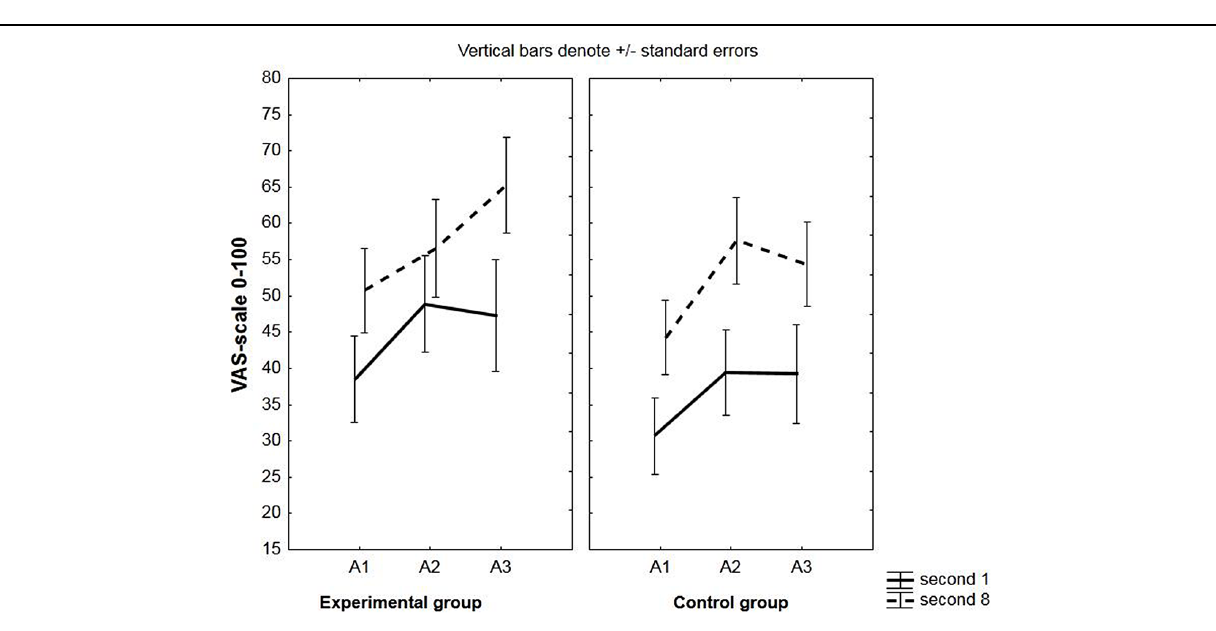
FIGURE 8 | US-expectancy during the CS-period in the subgroup of unaware participants. Mean US-expectancy ratings of second 1 and second 8 during the CS on a VAS-scale ranging from 0 (certainly no heavy breathing resistance) to 100 (certainly heavy breathing resistance) for the experimental and the control group during the three acquisition blocks (A1, A2,